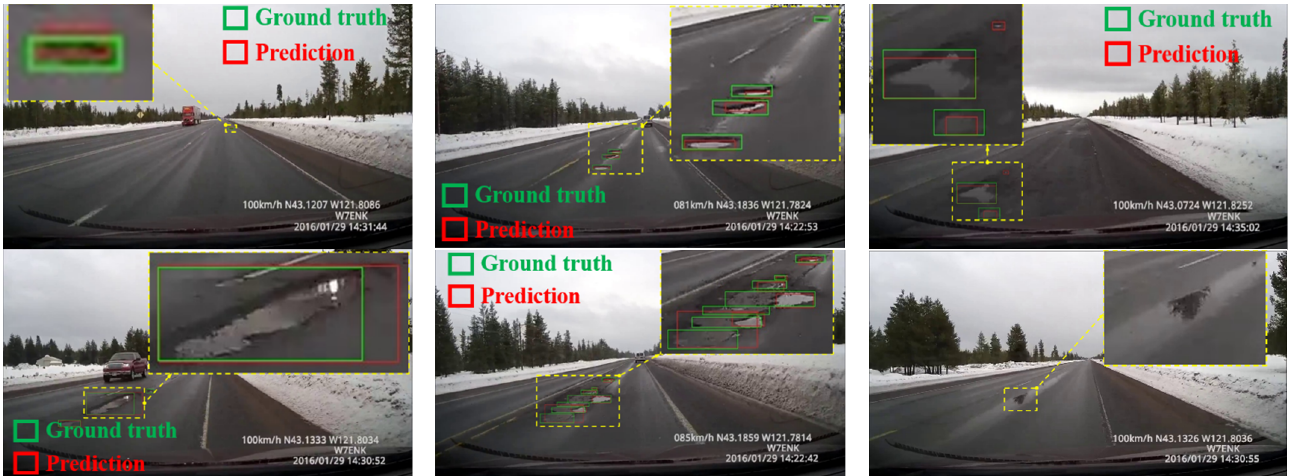
Figure 11. Pothole recognition results under severe conditions from the Pacific Northwest highway dataset.